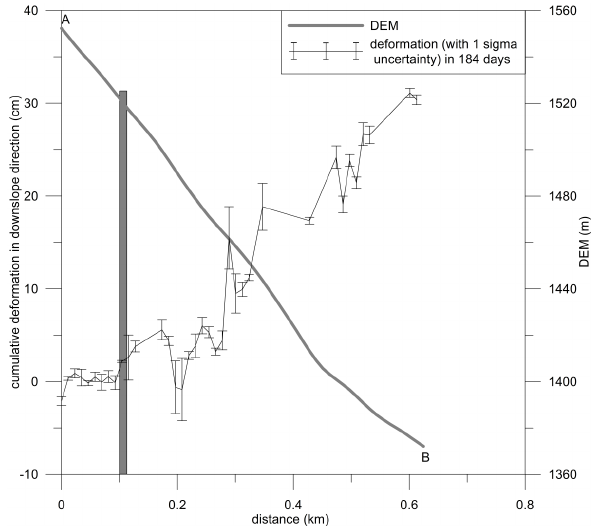
Fig. 7. Cumulative deformation in down-slope direction within 184 days and SRTM DEM along profile AB shown in Fig. 6. 1-sigma uncertainty indicates the InSAR deformation accuracy in down-slope direction. The vertical grey bar indicates the back crack point (shown in Fig. 6).